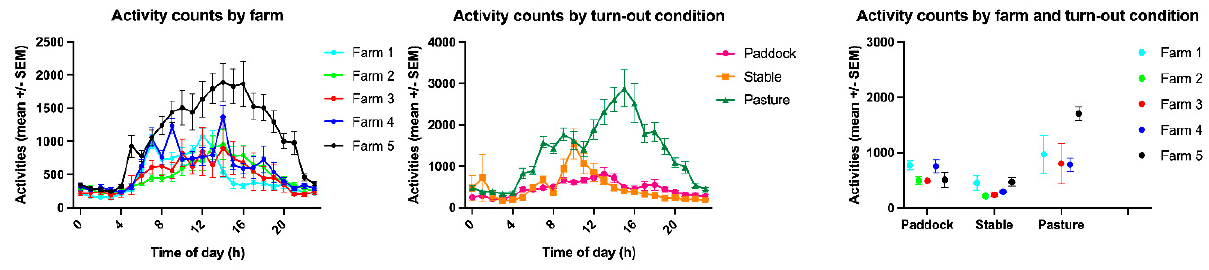
Figure 4. Activity counts by farm and turn-out condition detailed by time of day and by farm x turn-out condition.